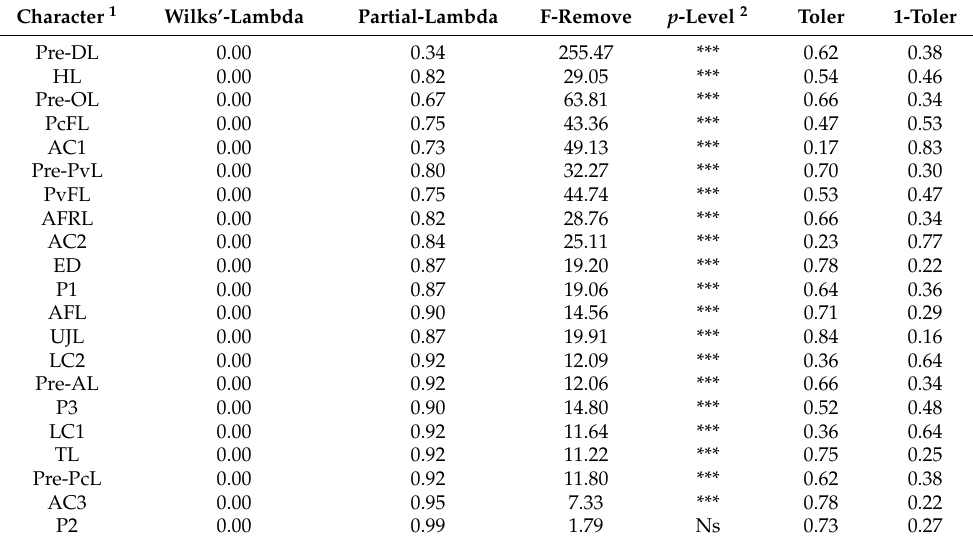
Table 3. Discriminant functions for the morphometric variables (fitted data) of six freshwater species from